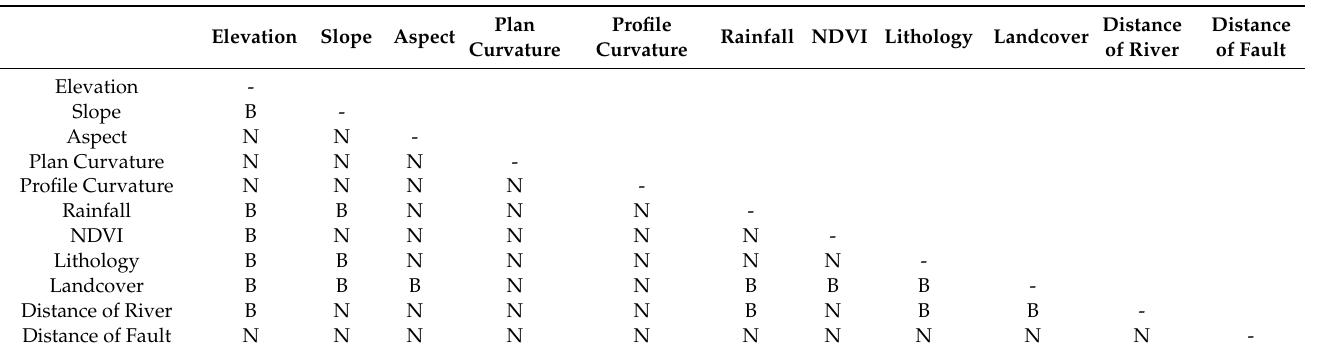
Table 2. The q -value of the interactions *.